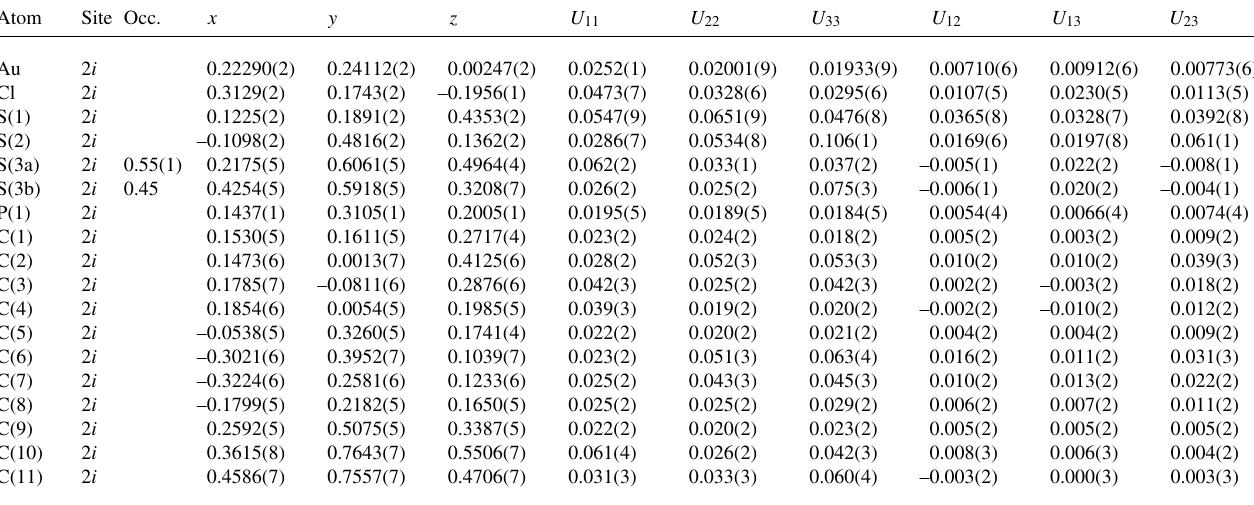
Table 3. Atomic coordinates and displacement parameters (in Å 2 )